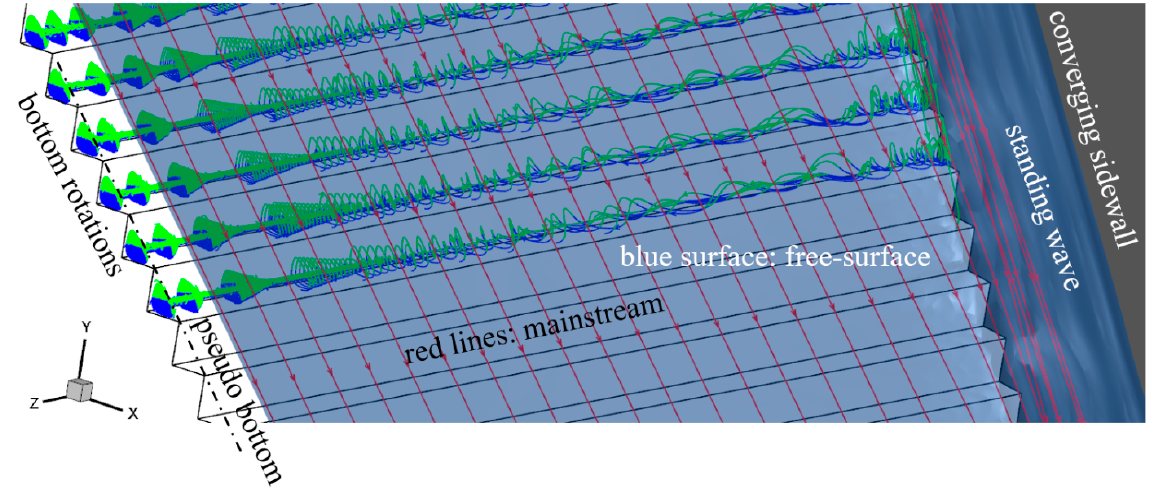
Figure 3. Typical skimming flow pattern of the converging stepped spillway with θ = 48.3°, B = 22.5 mm, h c / B = 3.36 and Φ = 22.6°. Blue surface: free-surface; red lines: mainstream; g reen and blue rotating lines: bottom rotations.